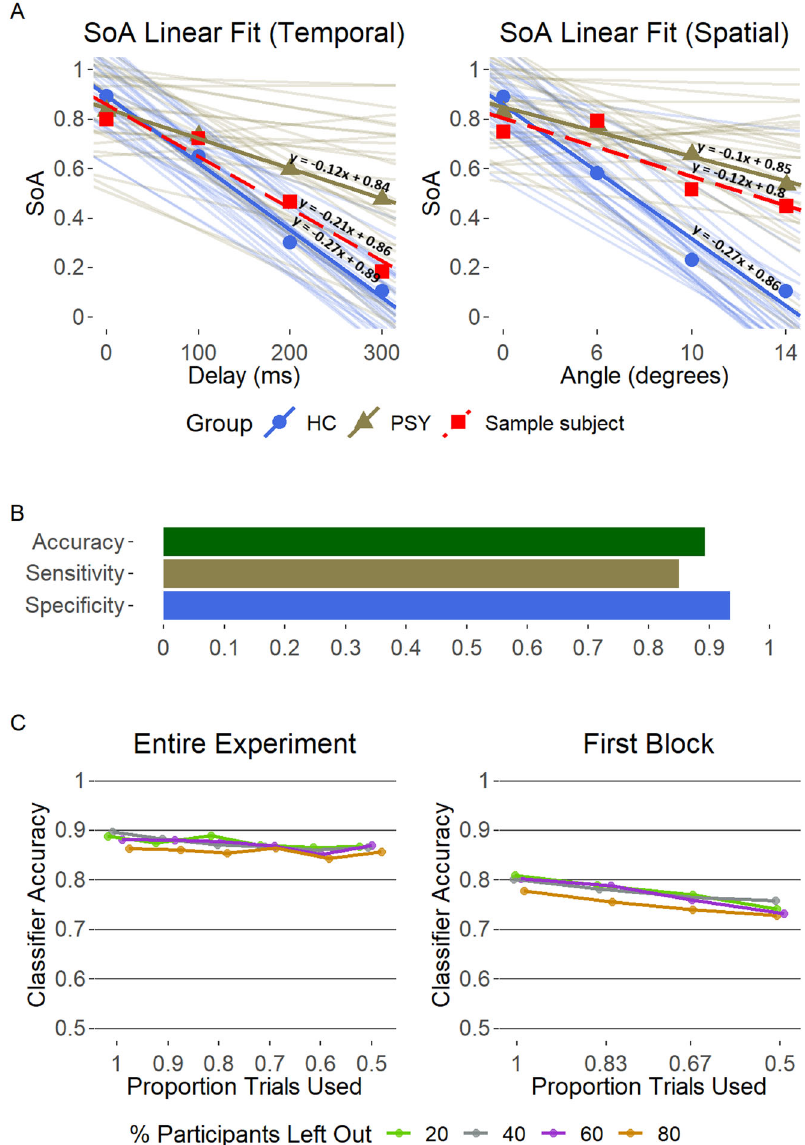
Fig. 2 Group classi fi er performance. A Classi fi cation of two sample subjects (exemplar control participant and psychosis patient, linear fi t in dashed red line), that are accurately classi fi ed as “ control ” (left) and “ psychosis ” (right). B Classi fi er performance, leaving out 20% of the participants (i.e. 6) in each iteration. Sensitivity is the percent of psychosis patients correctly classi fi ed, speci fi city is the percent of HC correctly classi fi ed. C Classi fi er accuracy across different proportions of participants left out and number of trials sampled. Trials were randomly sampled from the entire experiment (left), or from the fi rst block